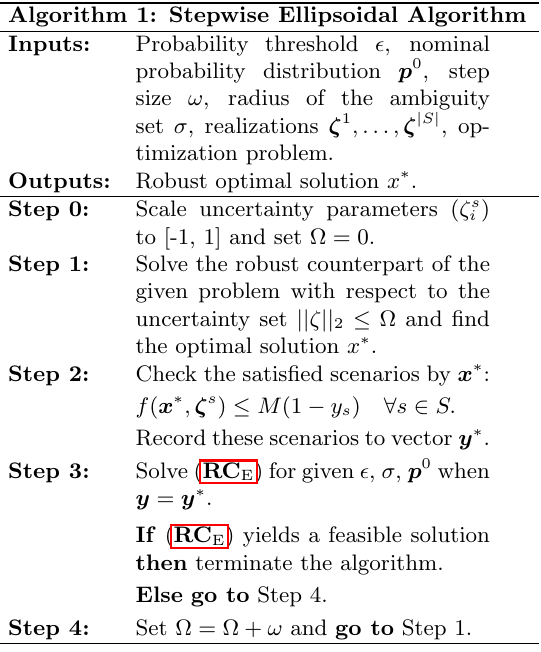
Algorithm 1: Stepwise Ellipsoidal